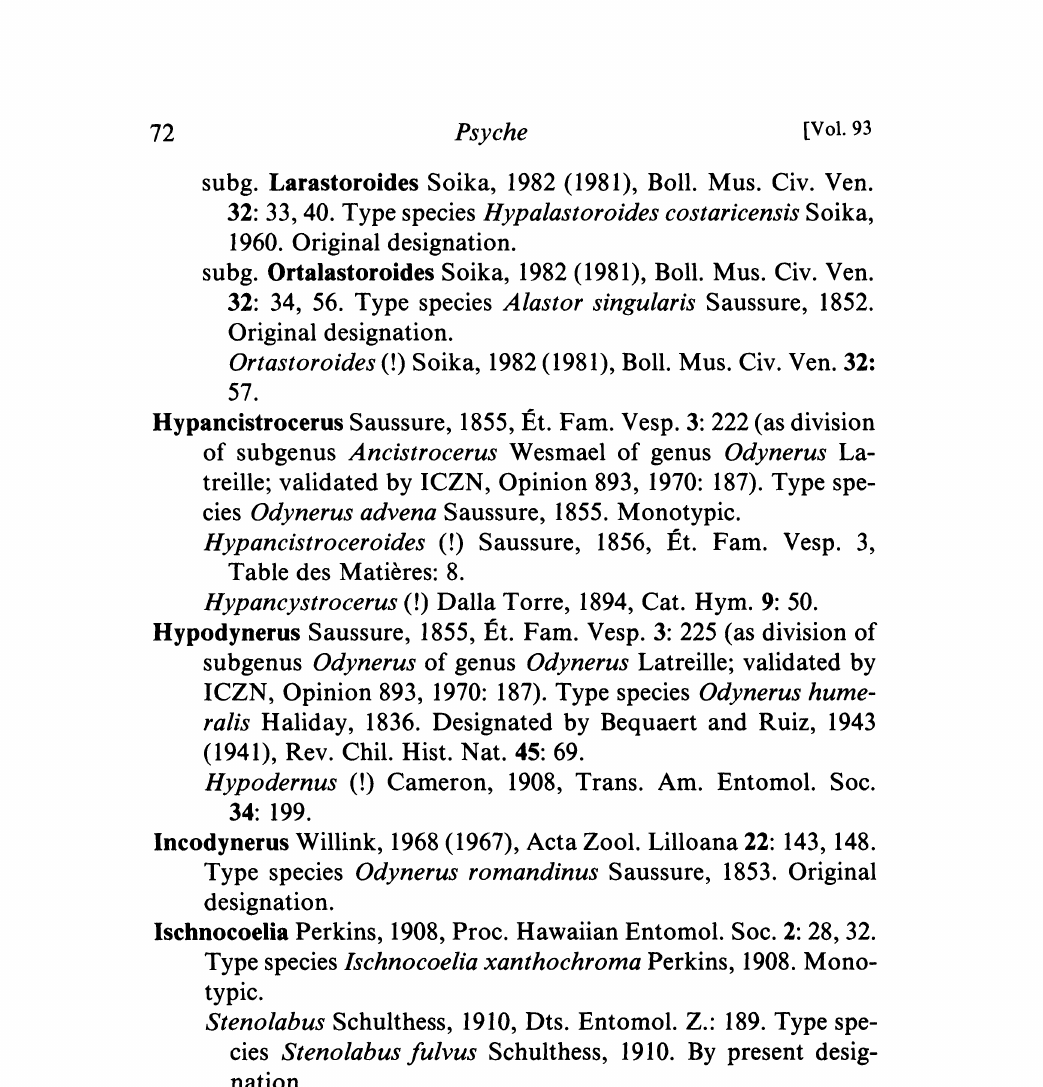
Table des Matires: